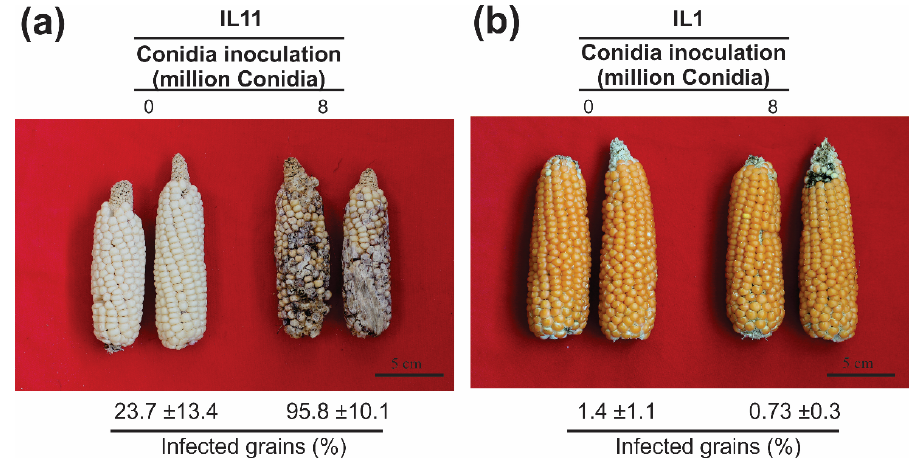
Figure 5. Fusarium effect on ears at the maturity (R6 stage). ( a ) Ears from the IL1 and ( b ) IL11 lines. In both panels, the ears on the left are the controls, whereas inoculated ears are on the right. Rot severity quantification was performed at the end of the cycle. The values show the percentage of infected grains. The different letters above the bars refer to significant differences using the Duncan mean test